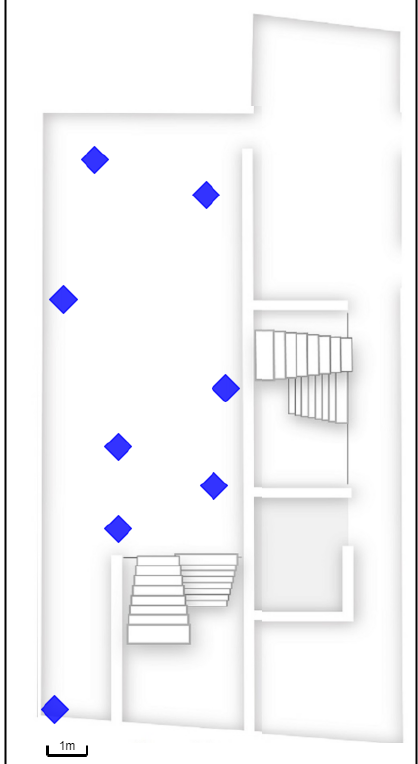
Figure 7. Placement of sensors within the